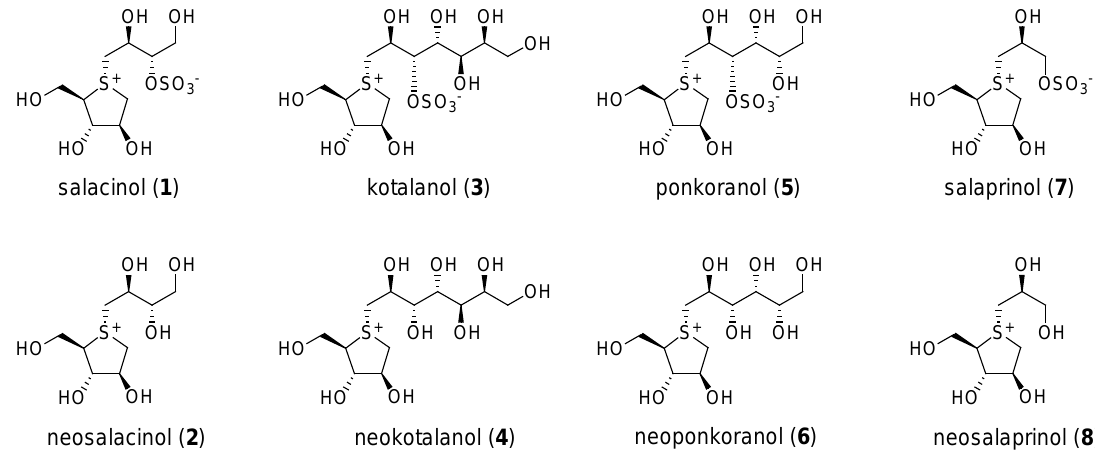
Figure 1. Sulfonium constituents ( 1 – 8 ) from the genus Salacia